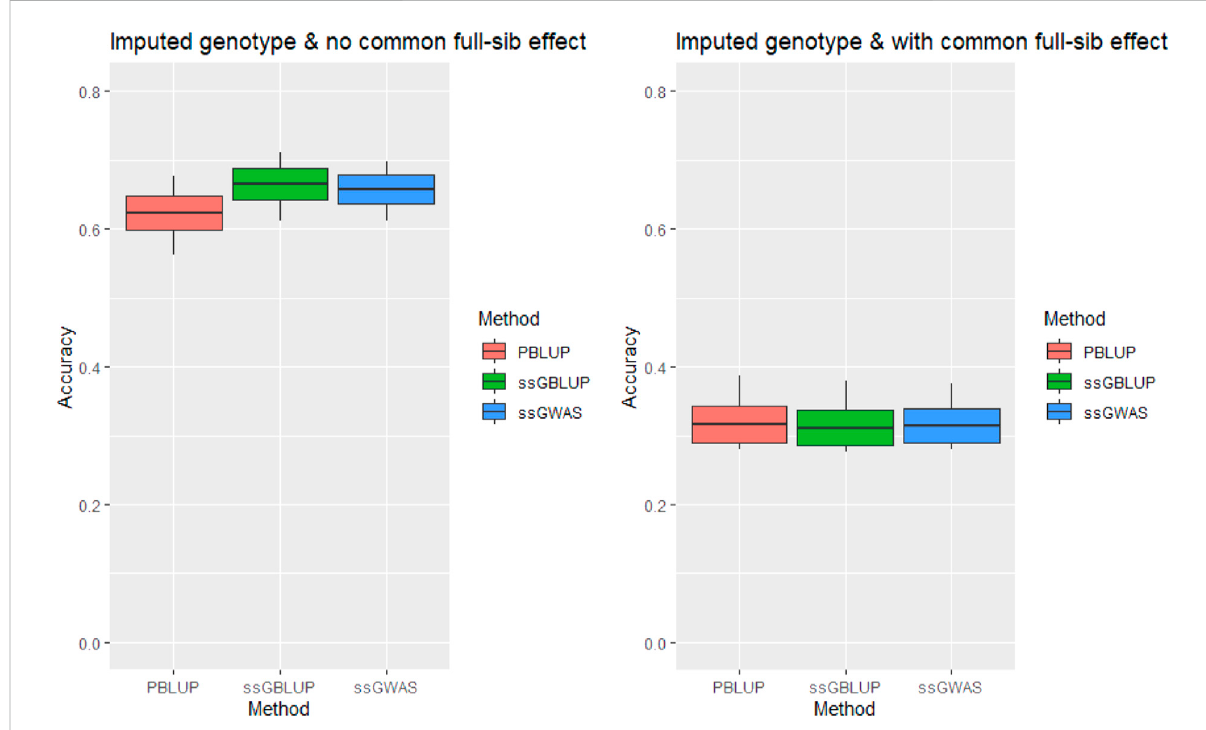
FIGURE 2 Accuracy of genomic prediction for tagging weight without/with common full-sib effect ( c 2 ) using imputed genotype under AI-REML algorithm. Middle line of the box is mean accuracy; top and bottom lines of the box is accuracy ± one standard deviation. End points of vertical line represent minimum and maximum